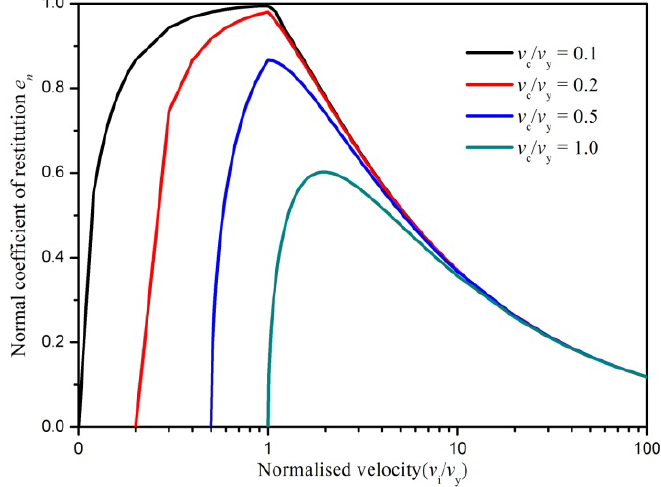
Figure 7. Theoretical prediction of the velocity dependent coefficient of